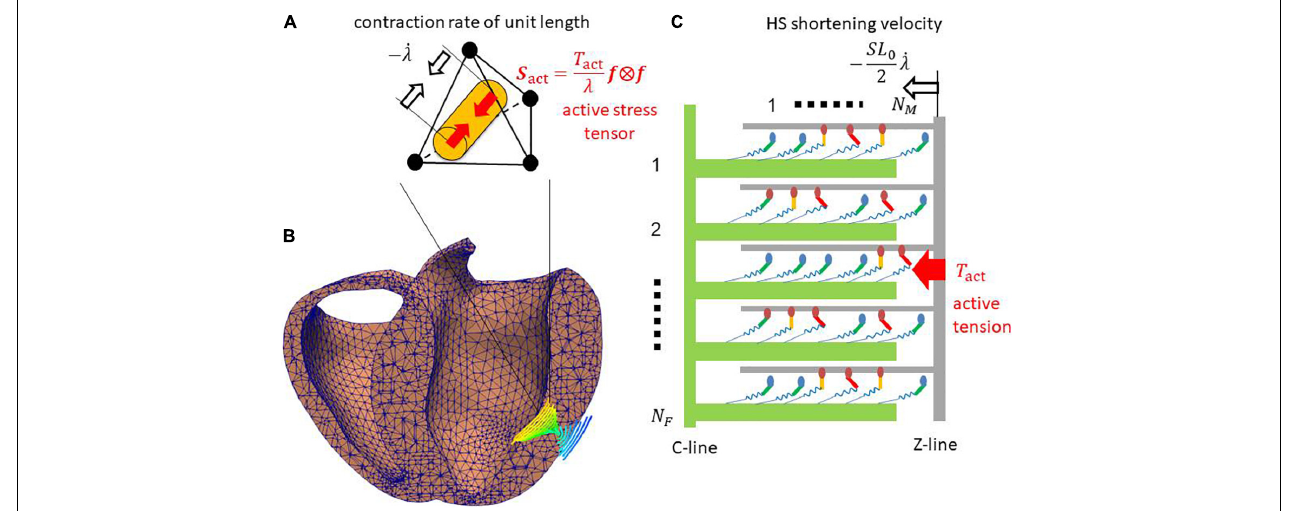
FIGURE 1 | (A) Tetrahedral element in (B) the ventricle wall of the FE model. The cylinder in panel (A) indicates the fiber orientation f that is shown in panel (B) using the integral curves colored according to the longitudinal component of f (blue: –1, red: +1). (C) The half-sarcomere model was assigned for each element. The active tension T act is given by summing the forces of the binding myosin molecules composed of the myosin head (ellipse), and the lever arm (bar) and rod (spring). In the half-sarcomere model, the C-line and thick filaments (green) are fixed. The Z-line and thin filament (gray) slide with the half-sarcomere (HS) shortening velocity − SL 0 ˙ λ / 2, where the stretch rate ˙ λ along the fiber orientation f is obtained from the FE model. The active tension T act is given by summing the forces generated by the binding myosin molecules, and it is used to define the macroscopic active stress tensor S act that drives the heartbeat in the FE